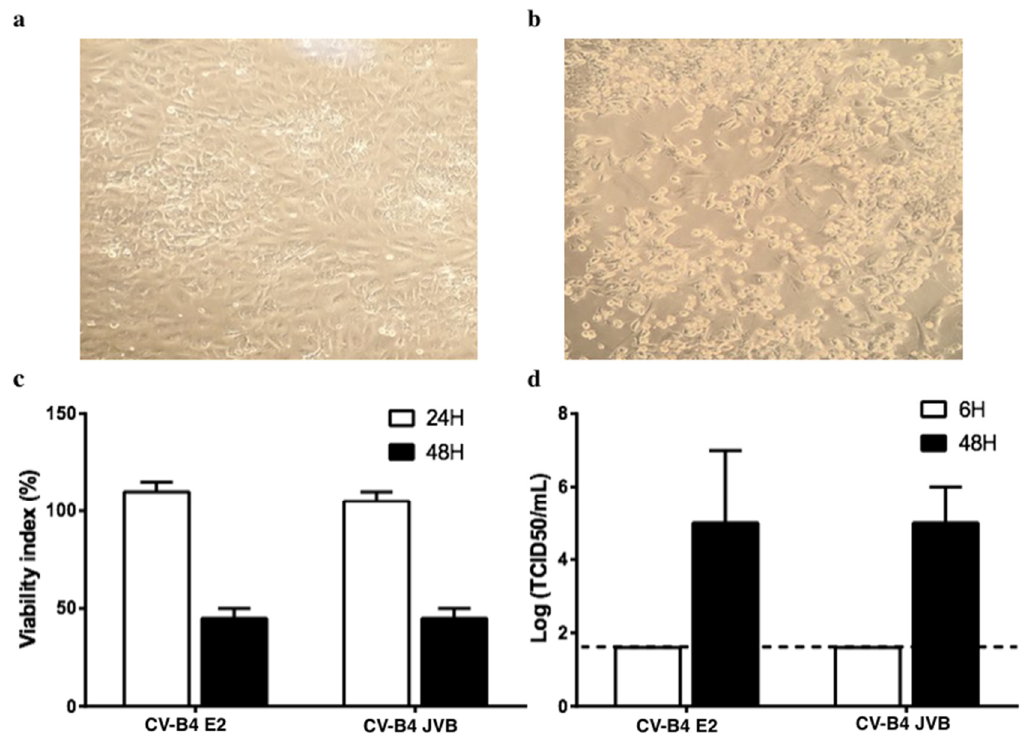
Figure 1. Cultures of primary human pancreatic ductal cells infected with Coxsackievirus B4 (CV-B4). ( a ) Pancreatic primary cells were obtained from five brain-dead donors. ( b ) Cultured cells infected with CV-B4 E2 or CV-B4 JVB (multiplicity of infection (MOI): 0.1) and observed under an inverted microscope (magnification × 100) after 48 h of incubation. ( c ) Viability of the cultured cells assessed using Orangu ® . Optical density values are normalized using the viability value of uninfected cells (mock = 100%). ( d ) The level of infectious viral particles in cultured supernatants harvested 6 and 48 h post-inoculation at MOI 0.1 determined by titration on HEp-2 cells. Results are expressed as TCID50 / mL. Means ± SD of log-transformed values of five independent experiments are shown.